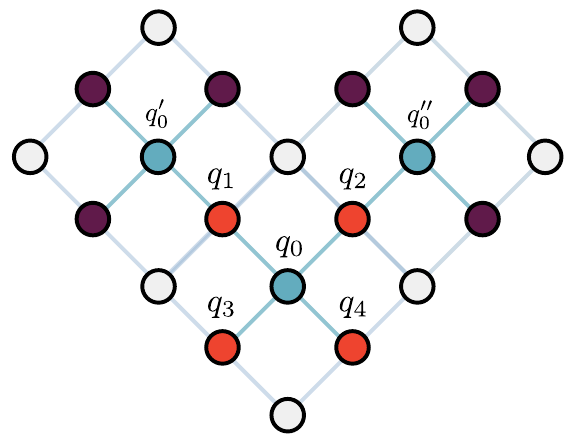
FIG. 6. Creating large W states rapidly on a square grid of qubits. We first prepare qubit 0 ( q 0 ) in its second excited state and carry out the rest of step 1 in Sec. II D 2 c to create | D 1 on the neighboring qubits (red circles). Next, we swap each of the neighboring qubits with the qubit next to them that is farthest from the center qubit (blue circles except q 0 ). Flipping the | 1 (cid:2) part of the state for these new center qubits to | 2 (cid:2) and having them interact with their nearest neighbors creates | D 1 bors (purple and red circles). For brevity, the new cells starting from q 3 and q 4 are not shown. The result after these steps (two rounds of single or simultaneous single-qubit operations, three rounds of simultaneous two-qubit gates) is the 16-qubit W state (cid:2) | D 1 16